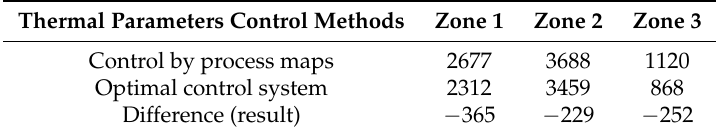
Table 1. Thermal load control results. Average flow of the mixed gas in the heat-treatment furnace by zone, m 3